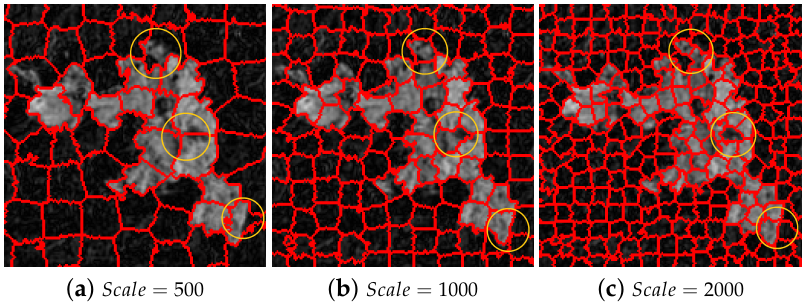
Figure 3. Subset of superpixel segmentation for Mexico at different